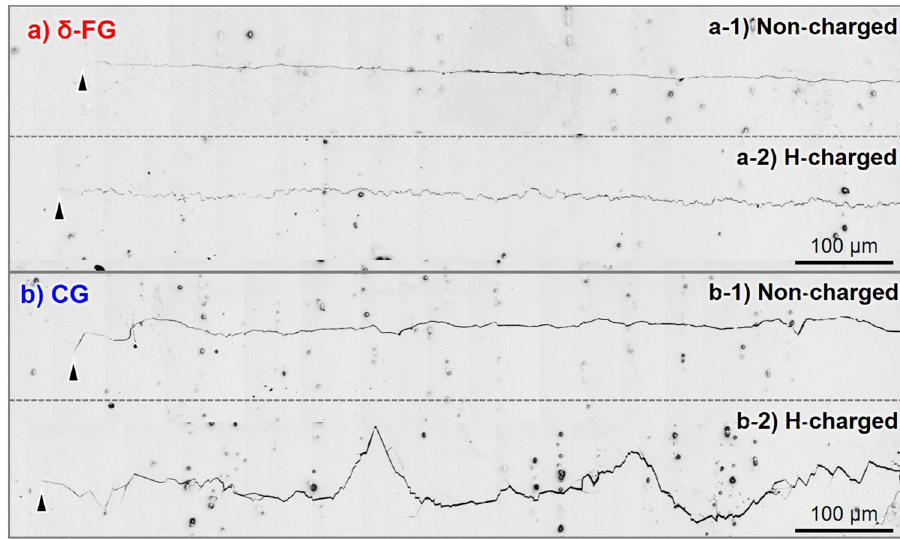
Figure 3. Macroscopic crack propagation pathways at Δ K = 20 MPa m 1/2 in ( a ) δ-FG and ( b ) CG, obtained by optical microscope: ( a-1,b-1 ) are for non-charged specimens. ( a-2,b-2 ) are for H-charged specimens. The arrowheads denote the crack